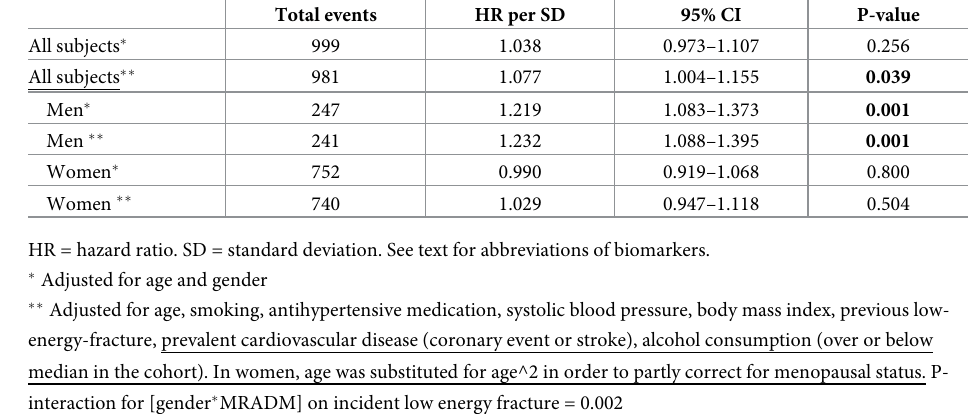
PLOS ONE | https://doi.org/10.1371/journal.pone.0203692 September 14,